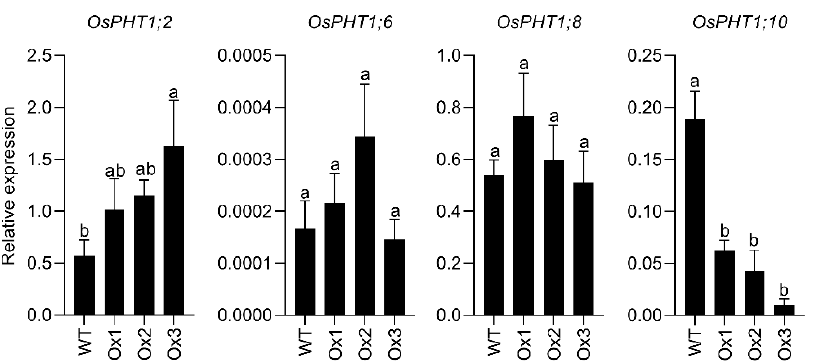
Figure 5. Expression of other OsPHT1 family genes ( OsPHT1;2, OsPHT1;6, OsPHT1;8, and OsPHT1;10 ) in the OsPHT1;4 -Ox lines. WT and Ox1–Ox3 seedlings (10-d-old) were grown hydroponically in the +P media for 1 week. Values are means ± SE ( n = 3). Different letters above the bars indicate significant differences ( p < 0.05, one-way ANOVA).